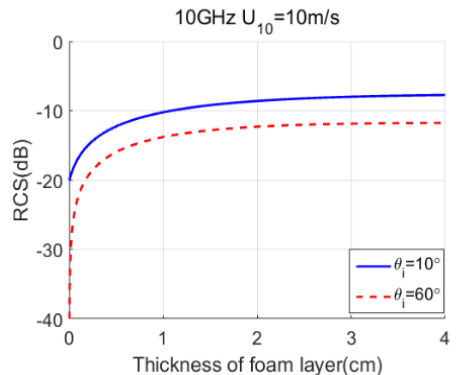
= 10 ◦ and θ = 60 ◦ i i